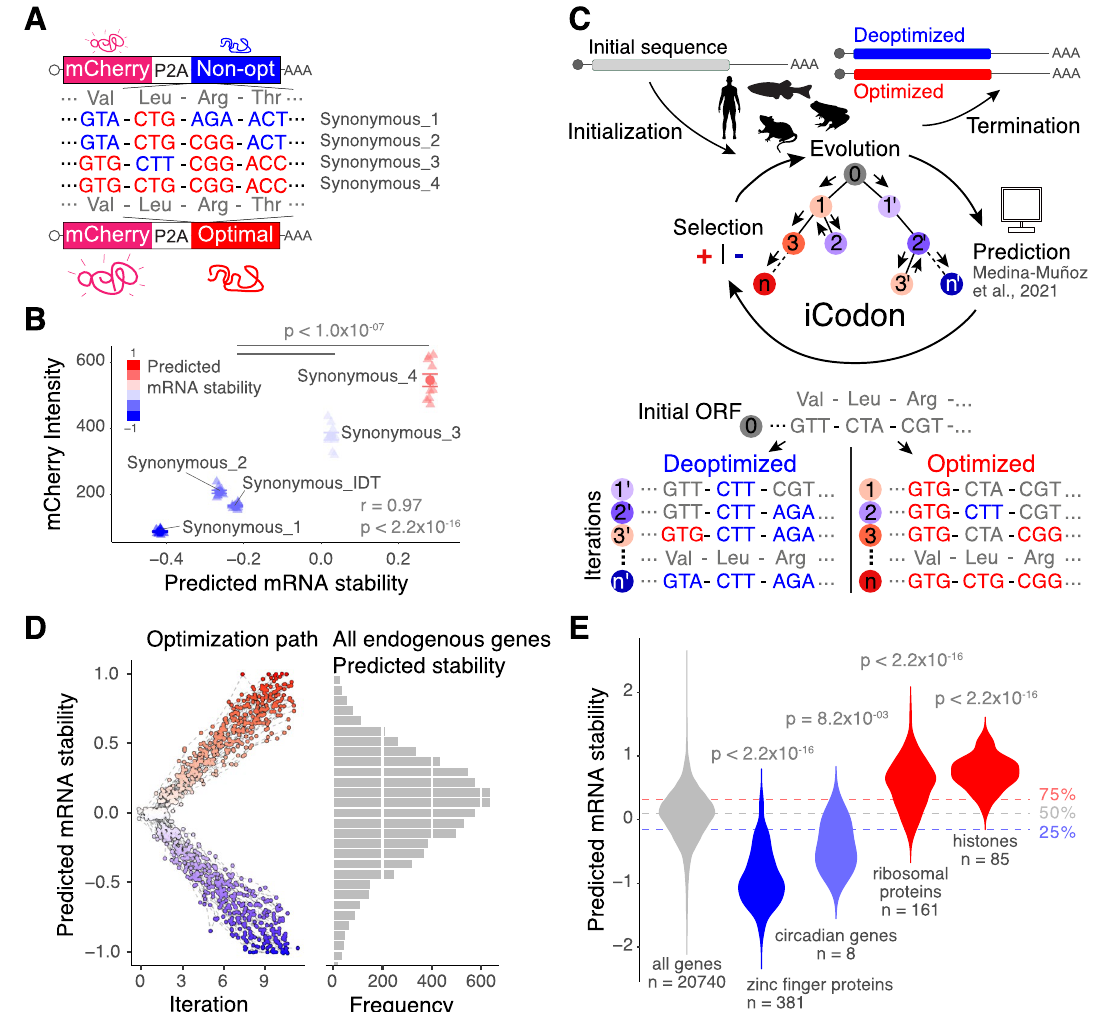
Figure 1. iCodon predicts gene expression based on the codon composition and designs new variants based on synonymous mutations. ( A ) Diagram of the synonymous reporters, differing only in synonymous mutations with different regulatory effects on mRNA stability. Each mRNA contains the coding sequence of mCherry fluorescent protein followed by a ribosome-skipping sequence (P2A) and a coding region that differs in the proportion of optimal and non-optimal codons but encodes the same peptide (synonymous mutations). ( B ) Scatter plot showing that fluorescence intensity of synonymous reporters in 293T transfected cells correlates with predicted mRNA stability (r = 0.97, p < 2.2 × 10 −16 , Pearson correlation test). n = 10 for all tested variants. ( C ) Diagram depicting the algorithm for codon optimization, iCodon: An initial coding sequence is provided by the user. Evolution: the algorithm generates variant sequences by introducing random synonymous mutations. Prediction: the machine learning model predicts the mRNA stability of each variant based on the codon composition. Selection: the algorithm selects the sequences with the highest or lowest mRNA stability depending on the direction of optimization. Iteration: this process is repeated multiple times producing an optimization path that generates a gradient in mRNA stability level. Illustrations by Mark Miller. ( D ) A random group of 50 human genes with predicted intermediate mRNA stability was selected and optimized and deoptimized by iCodon. The x-axis is the iteration number, and the y-axis is the predicted mRNA stability. The circles connected by a dash-line show the optimization or deoptimization path for each gene. The histogram on the right is the mRNA stability distribution for endogenous human genes. ( E ) Violin plot showing predictions of mRNA stability of selected groups of genes compared to all genes in the human transcriptome. The horizontal lines show the lower, middle and upper quartiles of the predicted mRNA stability of all genes. p values and number of genes (n) are